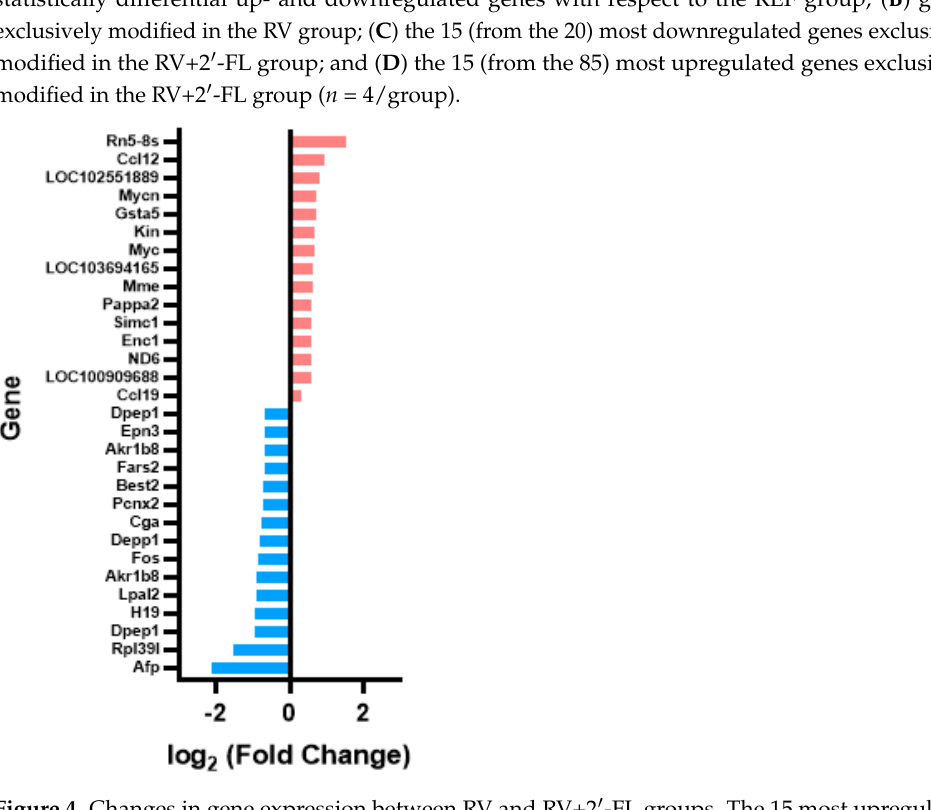
Figure 4. Changes in gene expression between RV and RV+2 ′ -FL groups. The 15 most upregulated genes (red) and the 15 most downregulated genes (blue) comparing the RV+2 ′ -FL group vs. RV group ( n = 4/group).